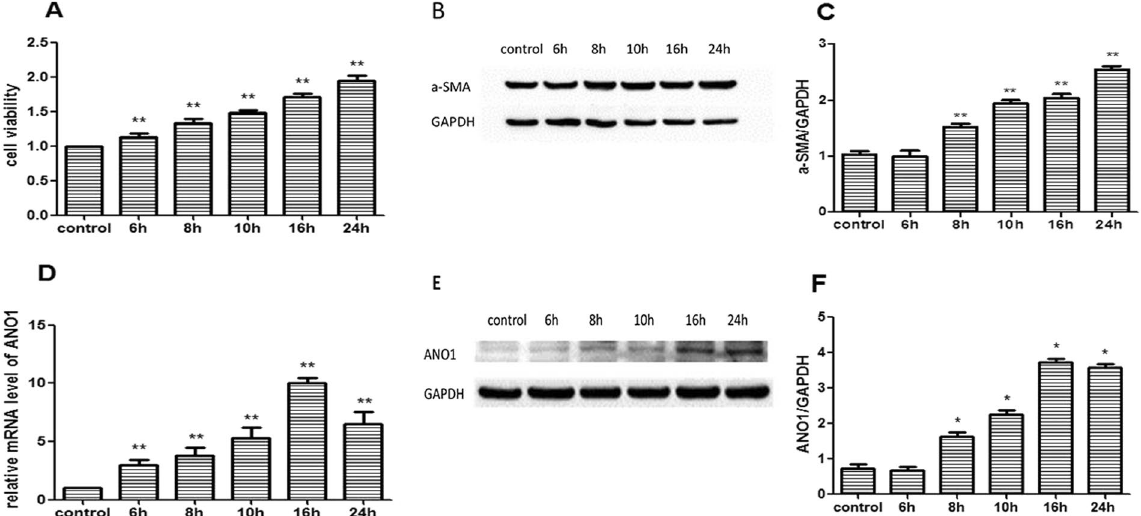
Figure 2. ANO1 expression and indicators expressions of cardiac fibrosis after hypoxia in cardiac fibroblasts. ( A ) MTT analysis showed cell viability growed gradually at 6, 8, 10, 16, and 24 hours after hypoxia. ( B and C ) a-SMA expression was gradually increased at 6, 8, 10, 16, and 24 hours after hypoxia compared to untreated group, and peaked at 24 hours by western blotting analysis. ( D ) Ano1 mRNA expression in cardiac fibroblasts at 6, 8, 10, 16, and 24 hours after hypoxia by qRT-PCR. ( E and F ) ANO1 protein expression in cardiac fibroblasts at 6, 8, 10, 16, and 24 hours after hypoxia by western blotting analysis. * p < 0.05, ** p < 0.01.